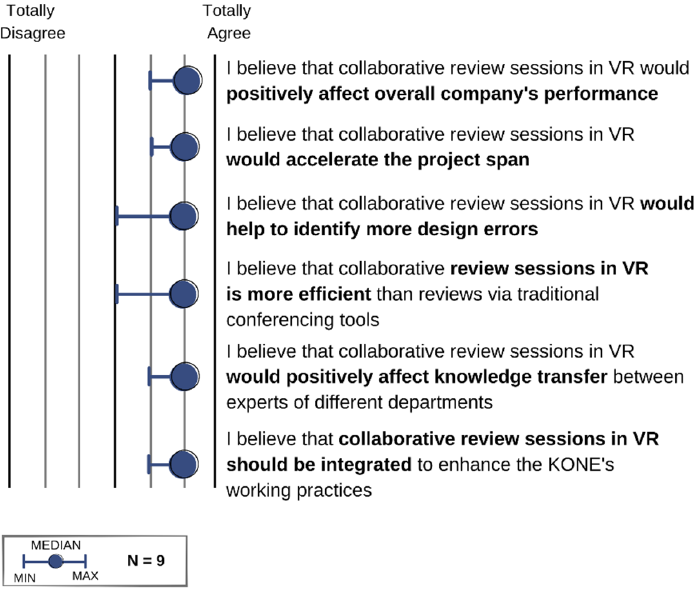
Figure 7. The results of collaboration-related statements, answered on a seven-point Likert scale.